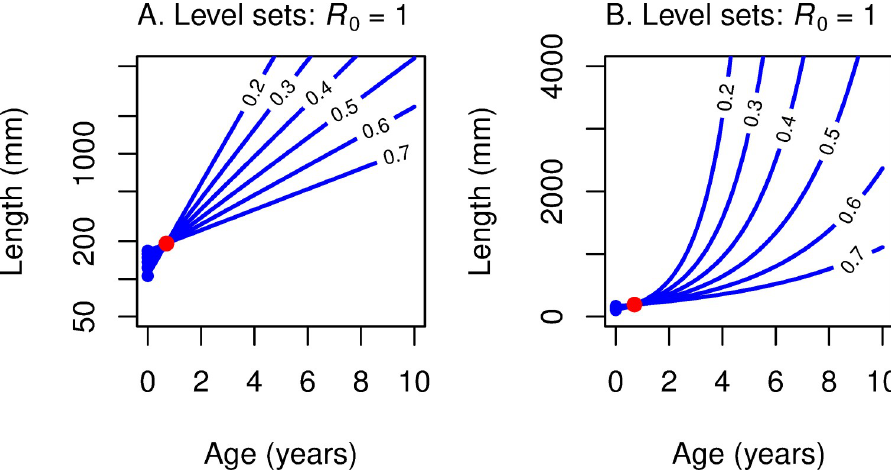
Fig 8. Level sets for R 0 = 1, r = 0 in age-length space, by annual survival. (A) With log-length on the vertical axis, iso- fitness lines are straight. (B) With linear-length on the vertical axis, iso-fitness lines are curved. As annual survival probability increases from s = exp(- z ) = 0.2 to 0.7, these level sets rotate clockwise about the red point ( y , L age-0 intercept (0, L α 0 ) increases. (See the blue curves in Fig